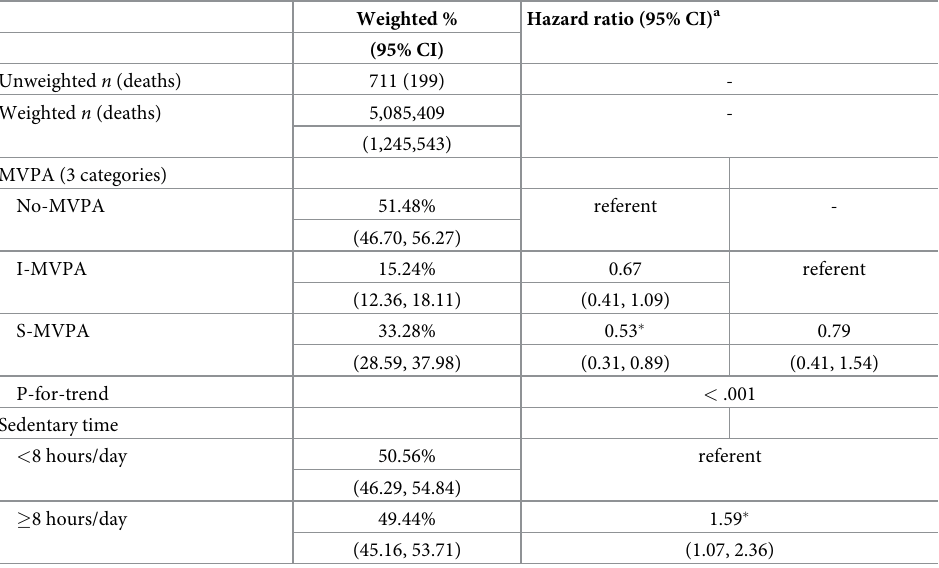
a the estimates were obtained from the Cox proportional hazard regression model adjusting for the study covariates retained using the backward elimination approach ( P < .20). The covariates retained in both models included age group, race/ethnicity, education, BMI group, marital status, and self-reported medical conditions on coronary heart disease, high cholesterol, diabetes, and walking difficulty